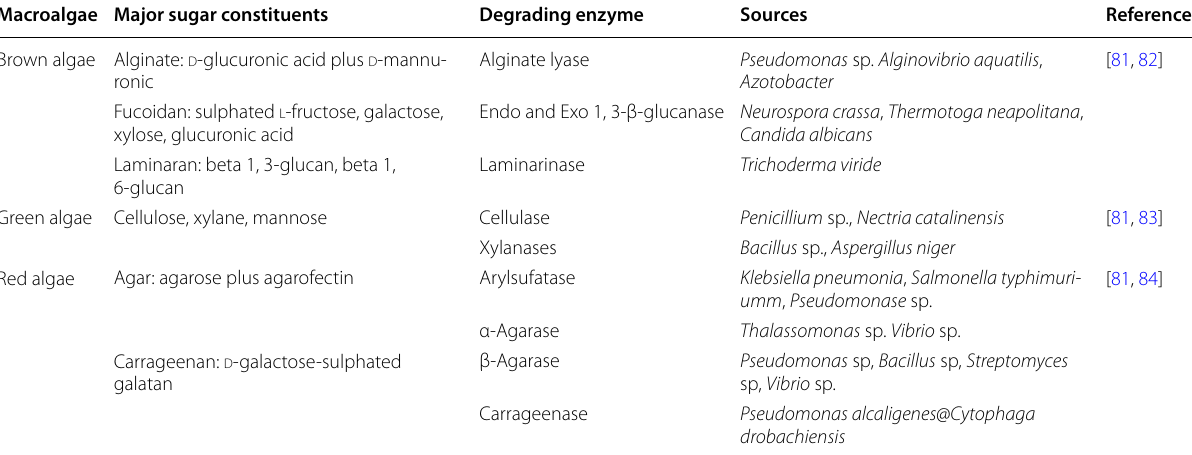
Table 3 Major sources of macroalgae that are responsible for degrading enzyme Macroalgae Major sugar